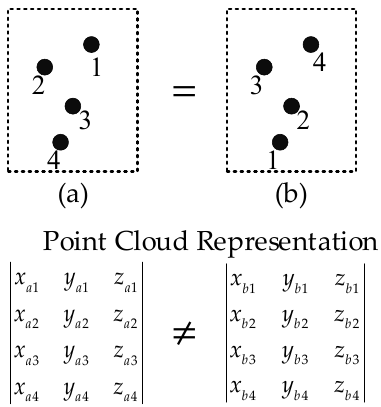
Figure 2. Disorder of point cloud. The point clouds in ( a , b ) have the same geometry, but the order of the points is different, and the expressions are also different. The structure of the network is shown in Figure